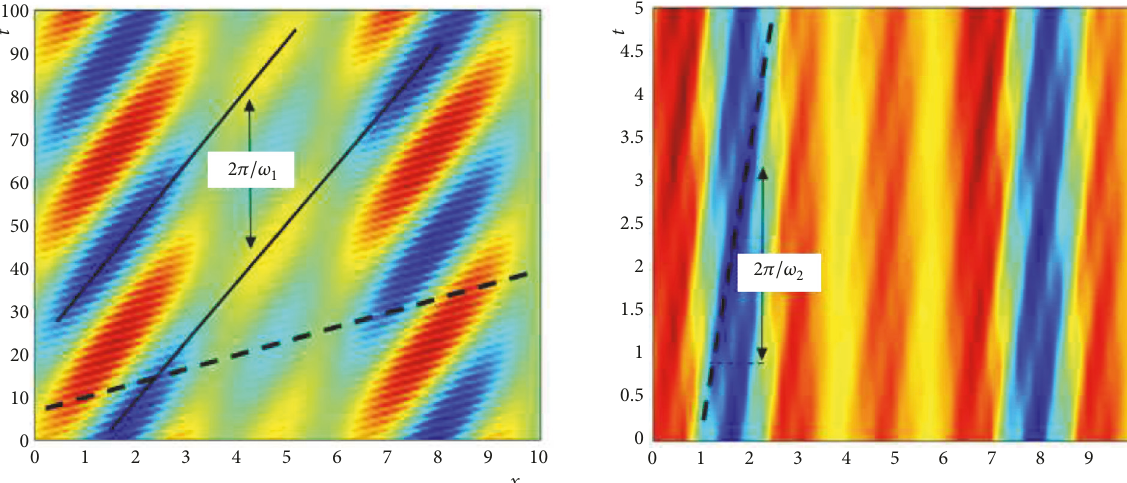
Figure 12: Color map of the toy model (50) (left plot) and its restriction to the sampled spatiotemporal square where the STKD method is applied (right plot).